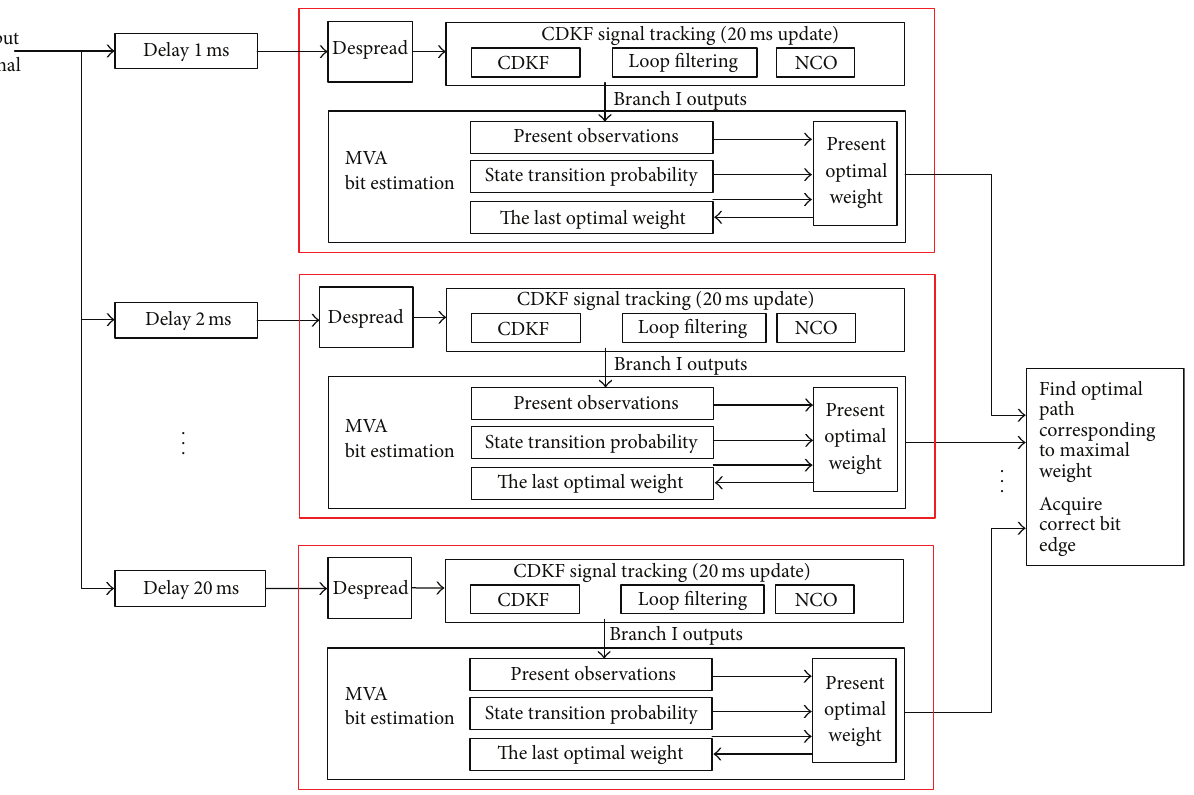
Figure 2: Parallel bit synchronized tracking scheme (scheme